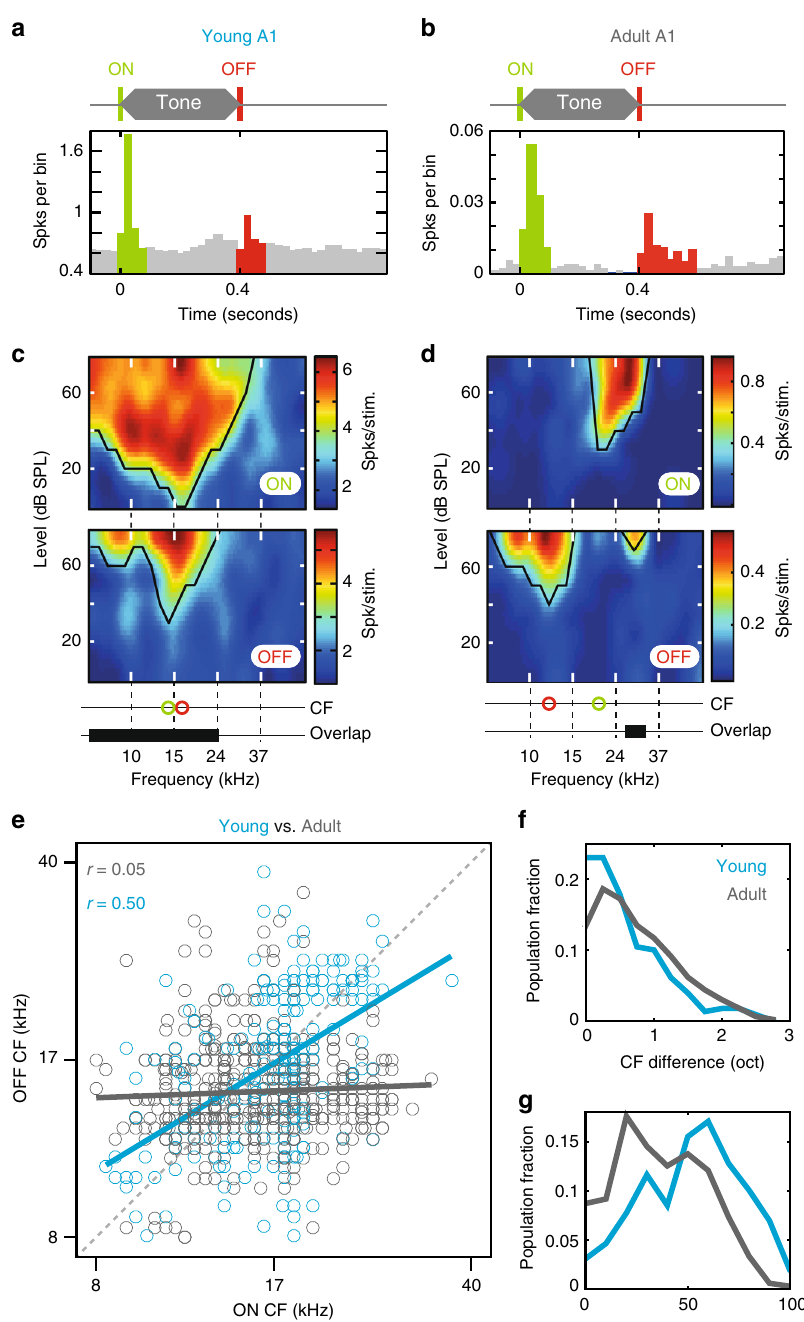
Fig. 1 Developmental divergence of ON and OFF receptive fi elds in primary auditory cortex. a , b Example peri-stimulus time histograms of spiking activity in A1 neurons of young (P15 – 23; a ) and adult (>P60; b ) mice responding to pure-tone onset (green) and offset (red). c Single neuron frequency response areas (FRAs) for sound onsets (top) and offsets (middle) in young mouse. Bottom, characteristic frequency (CF) was similar for onset and offset (green and red circles), and FRAs were overlapping (black bar). d Single neuron FRAs for sound onsets (top) and offsets (middle) in adult mouse. Bottom, CFs were segregated for onset and offset (green and red circles), and FRA overlap was limited (black bar). e Relationship between ON and OFF CF for individual A1 neurons in young (blue) and adult (grey) mice. The dashed diagonal line represents a perfect correspondence between ON and OFF CF. f Distribution of the absolute difference between ON and OFF CF for neurons in young (blue) and adult (grey) mice. g FRA overlap in young and adult mice. Receptive fi eld boundaries are largely overlapping early in development (blue) and later become segregated